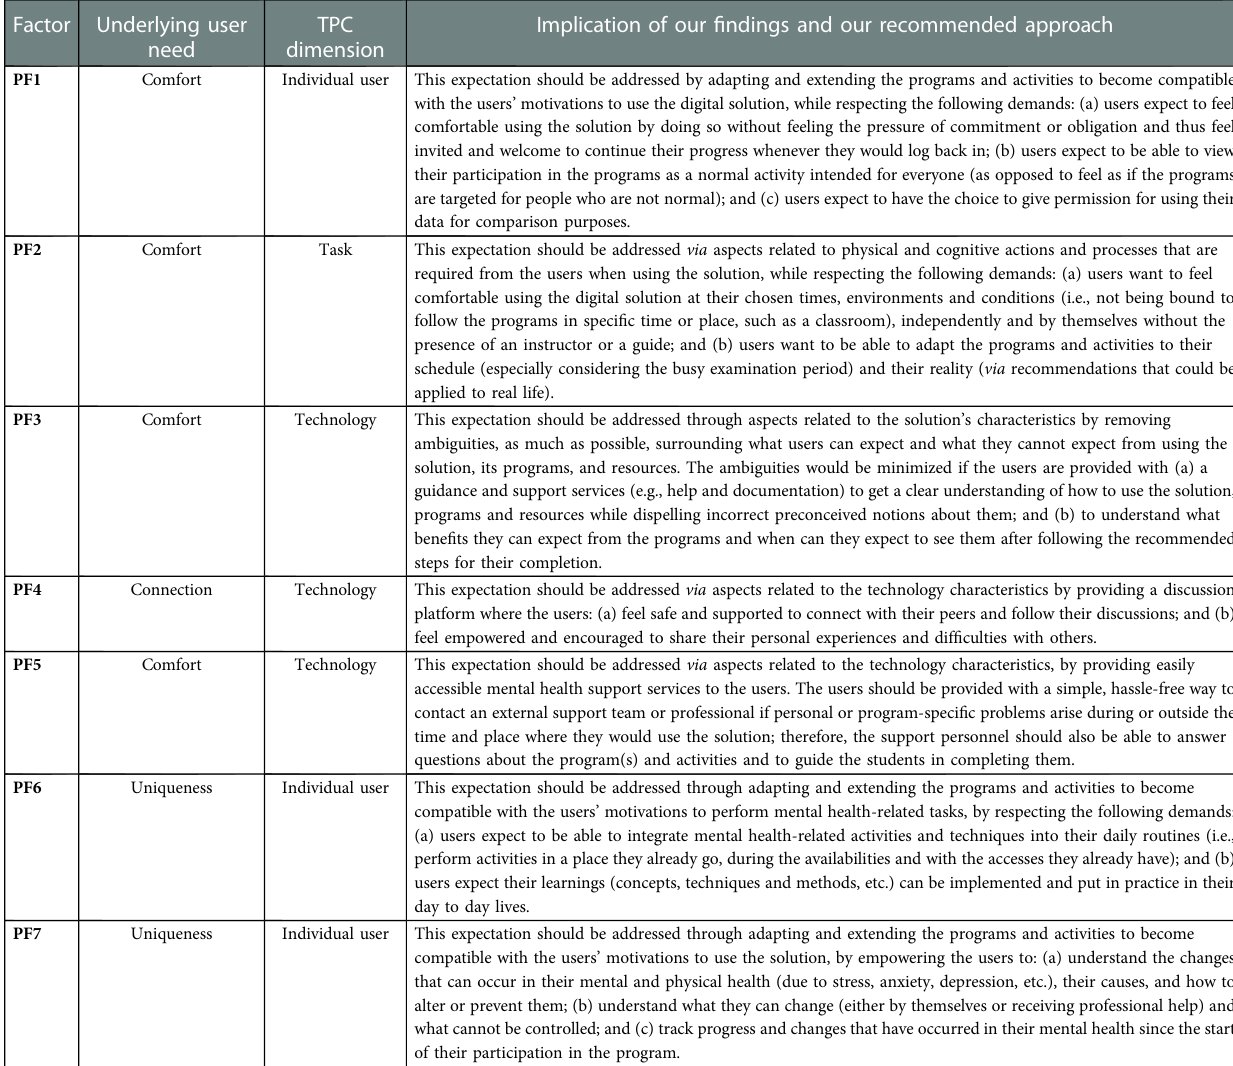
TABLE 1 Implications of the identi fi ed primary engagement factors and our